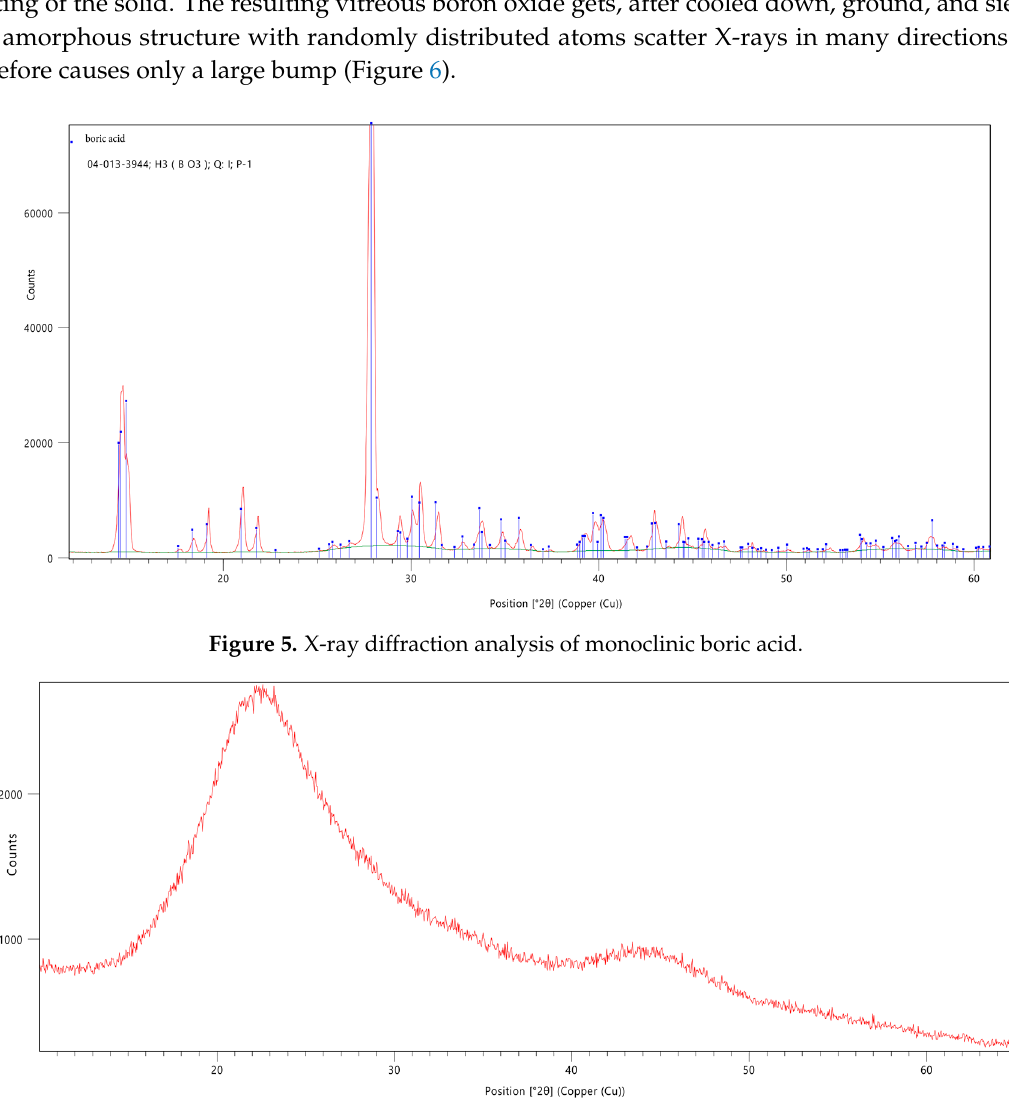
Figure 6. X-ray diffraction analysis of amorphous boron oxide.